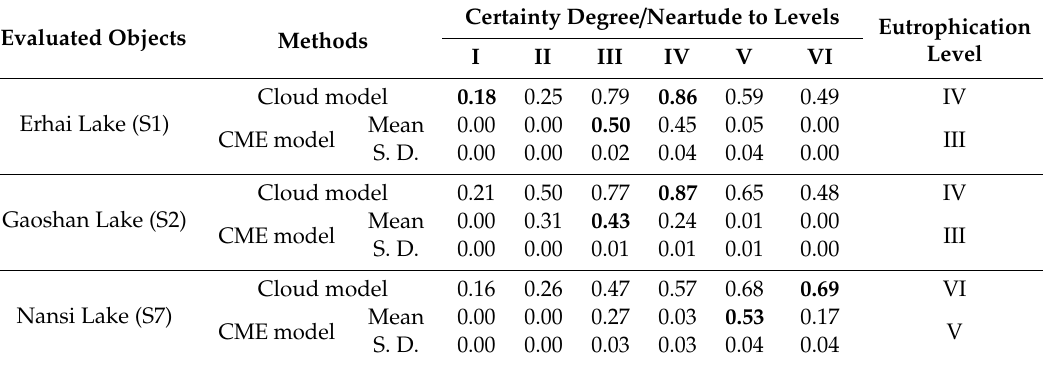
Table 8. Membership functions of cloud model and cloud matter element (CME) model for Erhai Lake (S1), Gaoshan Lake (S2), and Nansi Lake